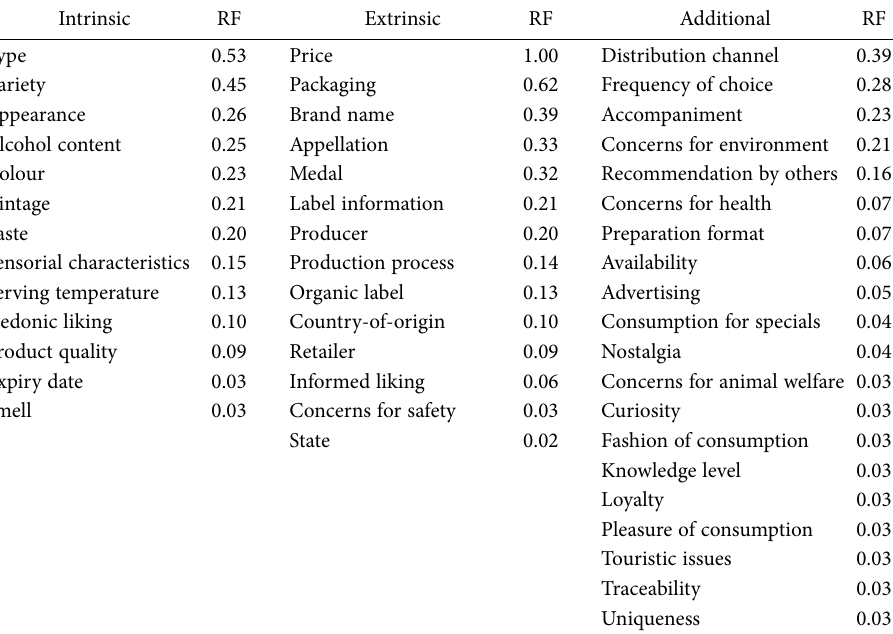
Table 2. Relative frequencies (RF) of intrinsic, extrinsic, and additional attributes in the sample.